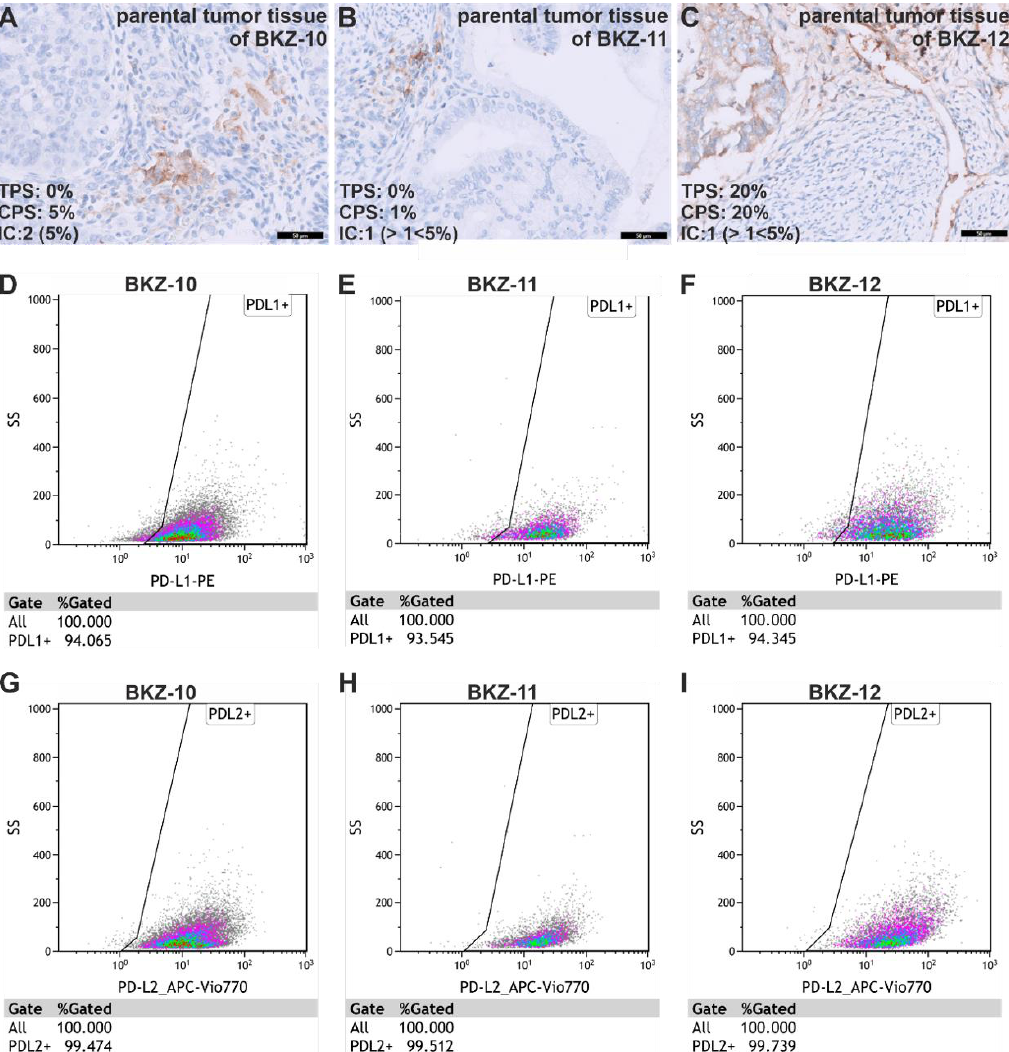
Figure 5. Isolated endometrial carcinoma-derived stem-like cell populations are enriched in PD-L1 and PD-L2 expression. ( A ) Immunohistochemical analysis of PD-L1 expression in the parental tissue of BKZ-10 revealed a tumor proportion score (TPS) of 0%, a combined positive score of 5% and an immune cell score (IC) of 2. ( B ) Analysis of PD-L1 expression in the parental tissue of BKZ-11 displayed a TPS of 0%, a CPS of 1% and an IC of 1. ( C ) For the parental tissue of BKZ-12, a TPS of 20%, a CPS of 20% and an IC of 1 was assessed. Analysis of PD-L1 ( D – F ) and PD-L2 ( G – I ) expression of endometrial carcinoma-derived cancer stem-like cell populations using flow cytometry revealed over 93% PD-L1-positive and 99% PD-L2-positive cells.